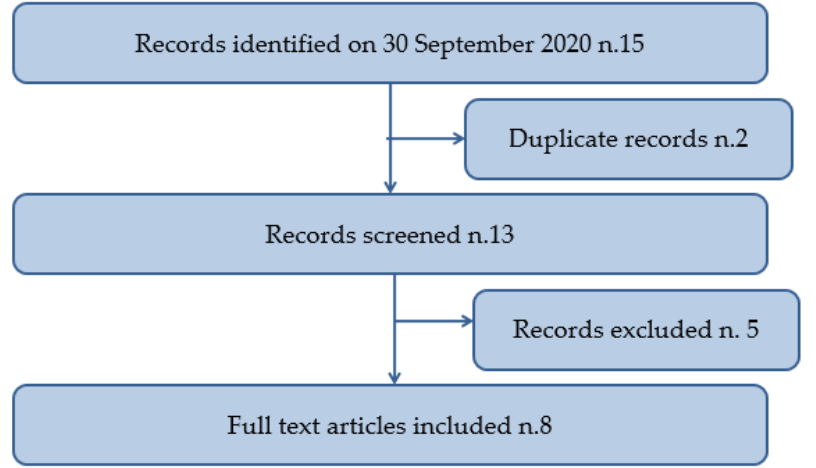
Figure 2. Flow diagram illustrating included and excluded studies in this systematic